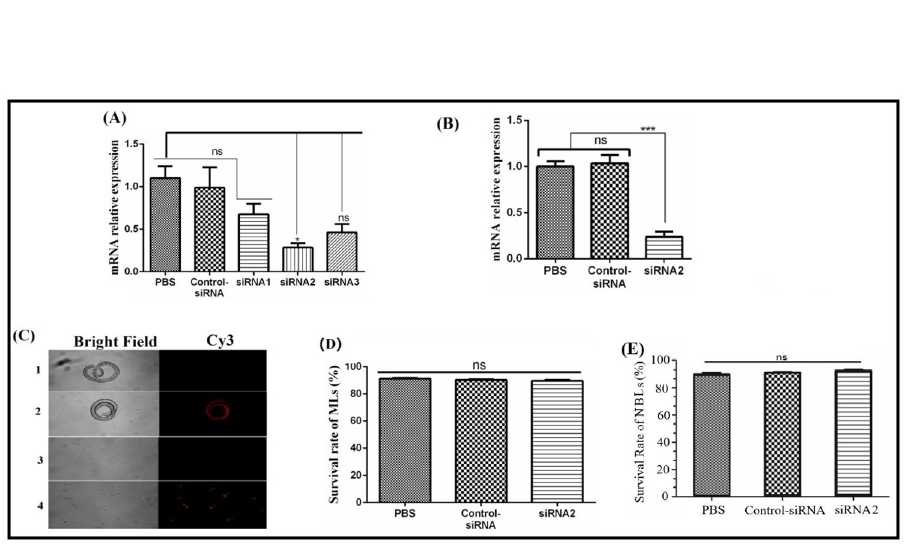
Fig 6. Knockdown of Tsp-GILT gene in ML and NBL. A: Tsp-GILT mRNA transcription level of MLs treated with siRNA1, siRNA2, siRNA3, control siRNA and PBS. B: Tsp-GILT mRNA transcription level of NBLs treated with siRNA2, control siRNA and PBS. C: Immunofluorescence assay of siRNA treated ML and NBL. Row 1: PBS treated ML; Row 2; Cy3 labeled control siRNA treated ML. Row 3: PBS treated NBL; Row 4; Cy3 labeled control siRNA treated NBL. Control siRNA treated ML and NBL showed transformation indicating red color. While, no color was observed in both control groups. D: Survival rate (%) of ML and NBL (E) in vitro after suppression of Tsp-GILT expression by siRNA2. The significant level was set at � P < 0.05, and ns non-significant compared with control group.